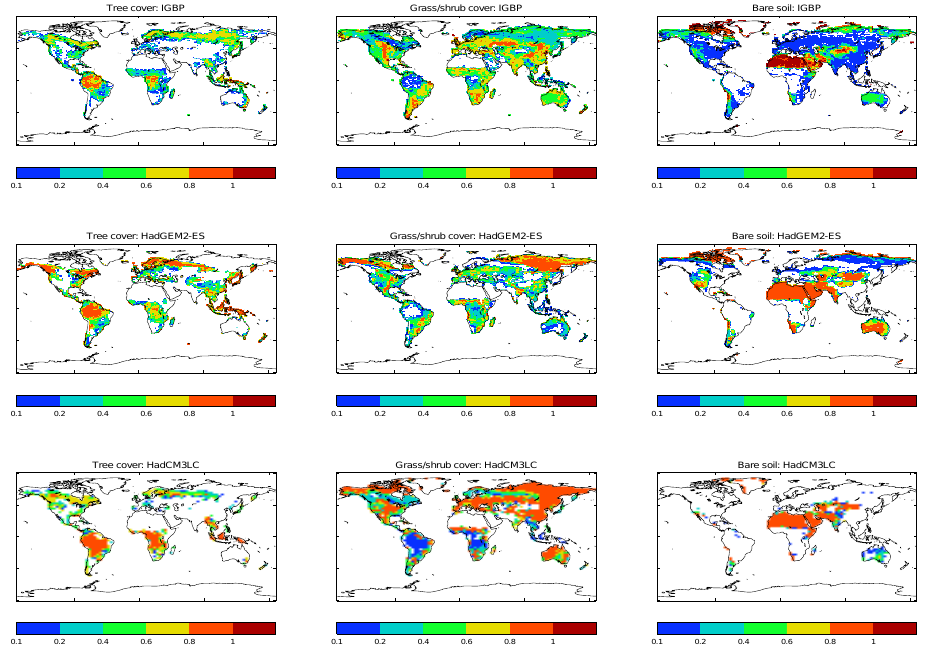
Fig. 15. IGBP Climatology and HadGEM2-ES simulation of tree cover (defined as the total of both broadleaf and needleleaf tree), grass, shrub and bare soil.